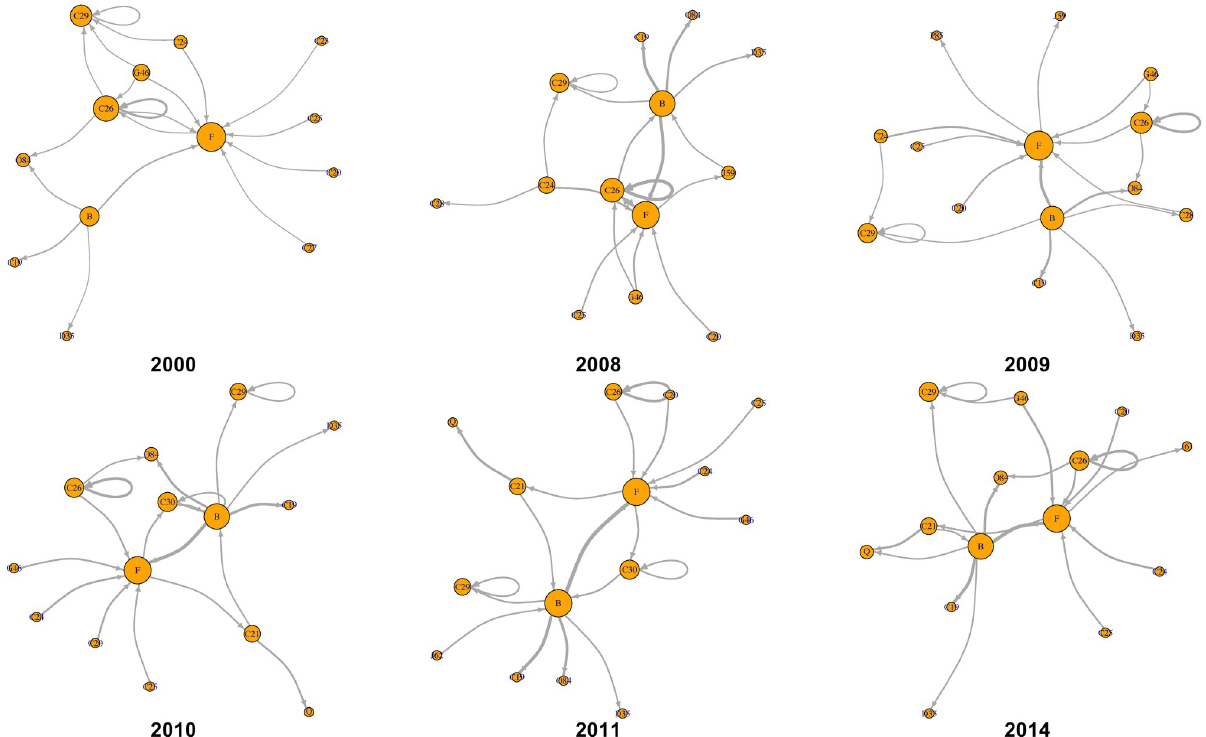
Fig 15. Intersectoral value-added circulation of the Pacific Rim community in 2000, 2008–2011, and 2014. These graphs illustrate the top 20 links. Their node sizes and link widths are in proportion to the square root of the degree and the amount of circular flow, respectively. S2 Table shows a detailed list of the